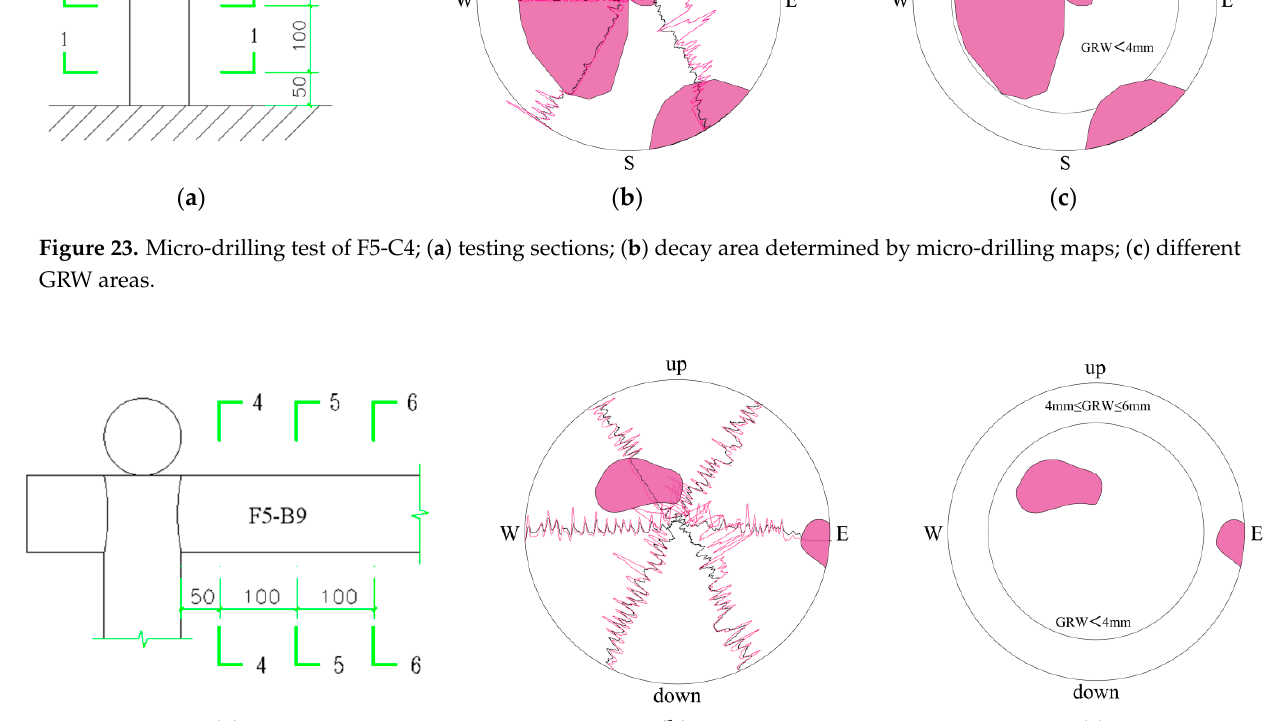
Figure 24. Micro-drilling test of F5-B9; ( a ) testing sections; ( b ) decay area determined by micro-drilling maps; ( c ) different GRW areas.